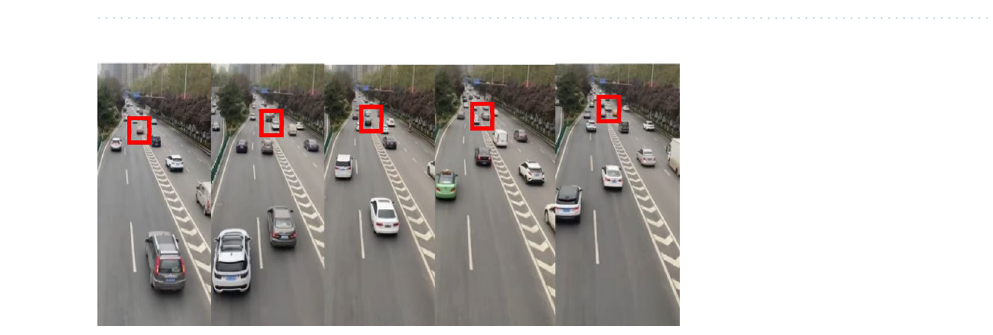
Figure 10. Probability of the target vehicle pass (left:Pr1)/yeild (right:Pr2) when the intention of interact vehicle is uncertain after optimization (t = π/2).